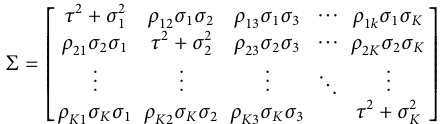
(Table S2), where number of studies, heterogeneity across studies, variation within-studies, overall effects,